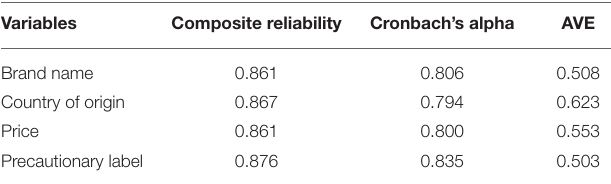
TABLE 7 | Reliability